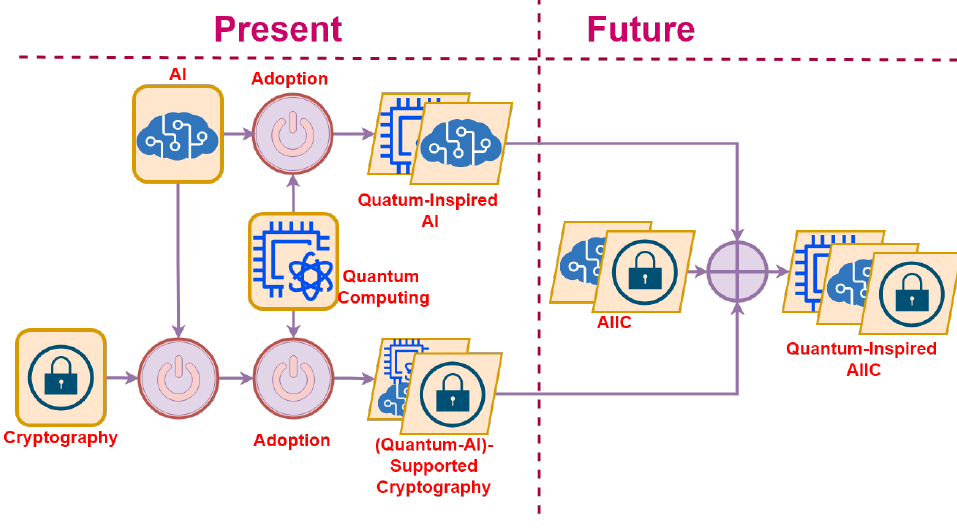
Figure 8. The Future of